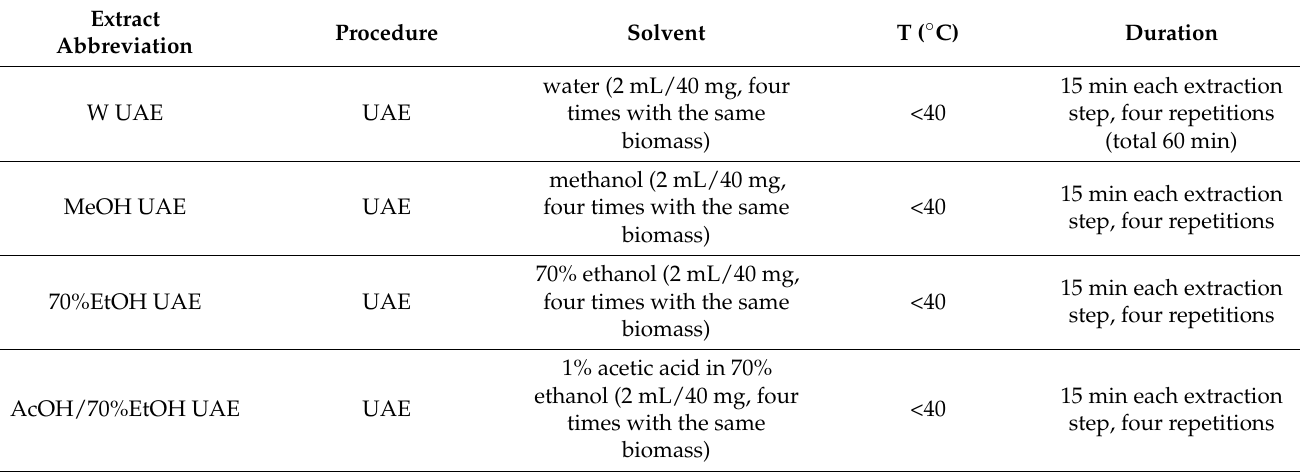
Table 1. List of different extraction methods of N. oculata . Details on the solvents, solvent-to-biomass ratio, temperature, and time of extraction are provided. Superscript numbers provide the earlier references of the extraction methods, which were used as they were or after minor